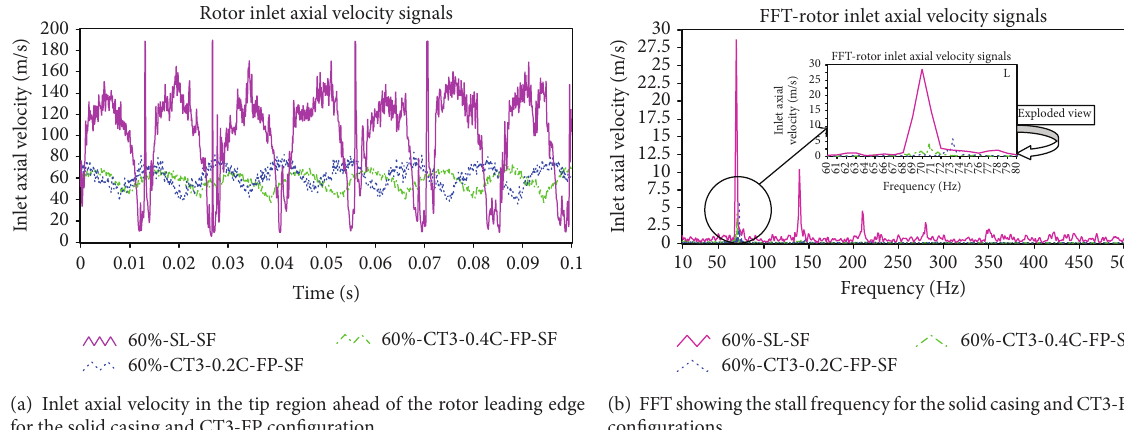
Figure 16: Comparative variations of inlet axial velocity for the solid casing and CT3-FP configuration at 60% operating speed at stall flow (SF) condition for 20% and 40% axial coverage.